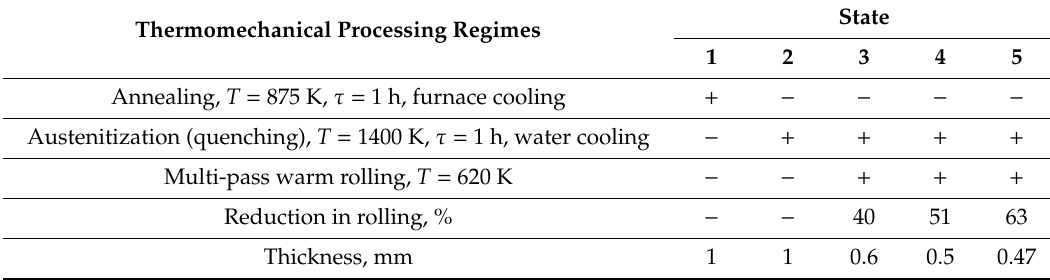
Table 2. Thermomechanical Processing